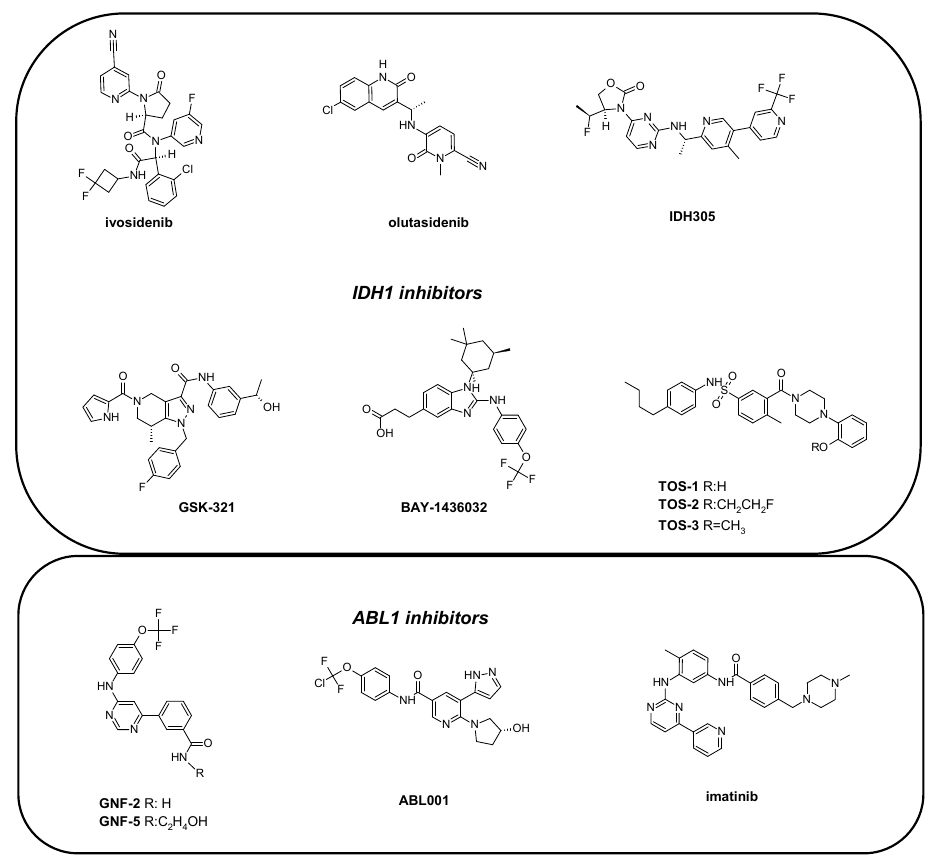
Figure 2. The inhibitors of isocitrate dehydrogenase – IDH1 (upper box) and ABL1 tyrosine kinase (lower box) that are relevant to this study.